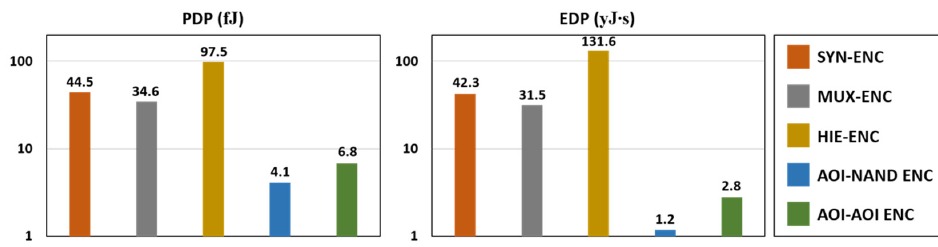
Figure 7. PDP and EDP comparisons. Y axes are in log scale.